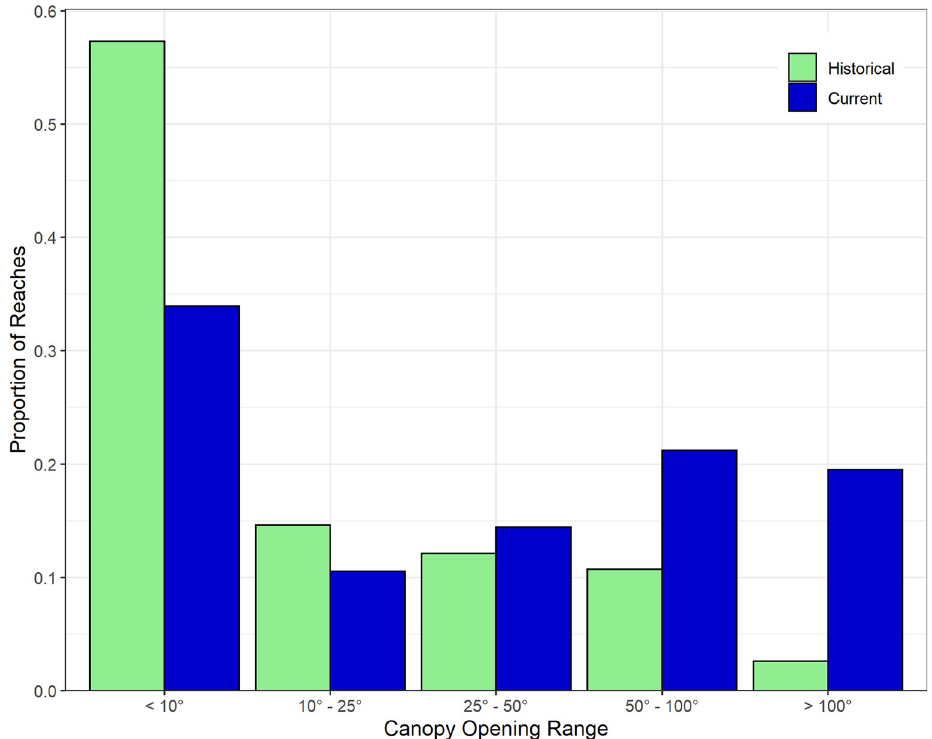
Fig 6. Change in stream shade (canopy opening angle). Frequency distributions (proportion of total reaches) of natural potential and current canopy opening angles in the Chehalis River basin. Note the large increase in very wide canopy opening angles ( > 100˚) and large decrease in narrow angles ( <